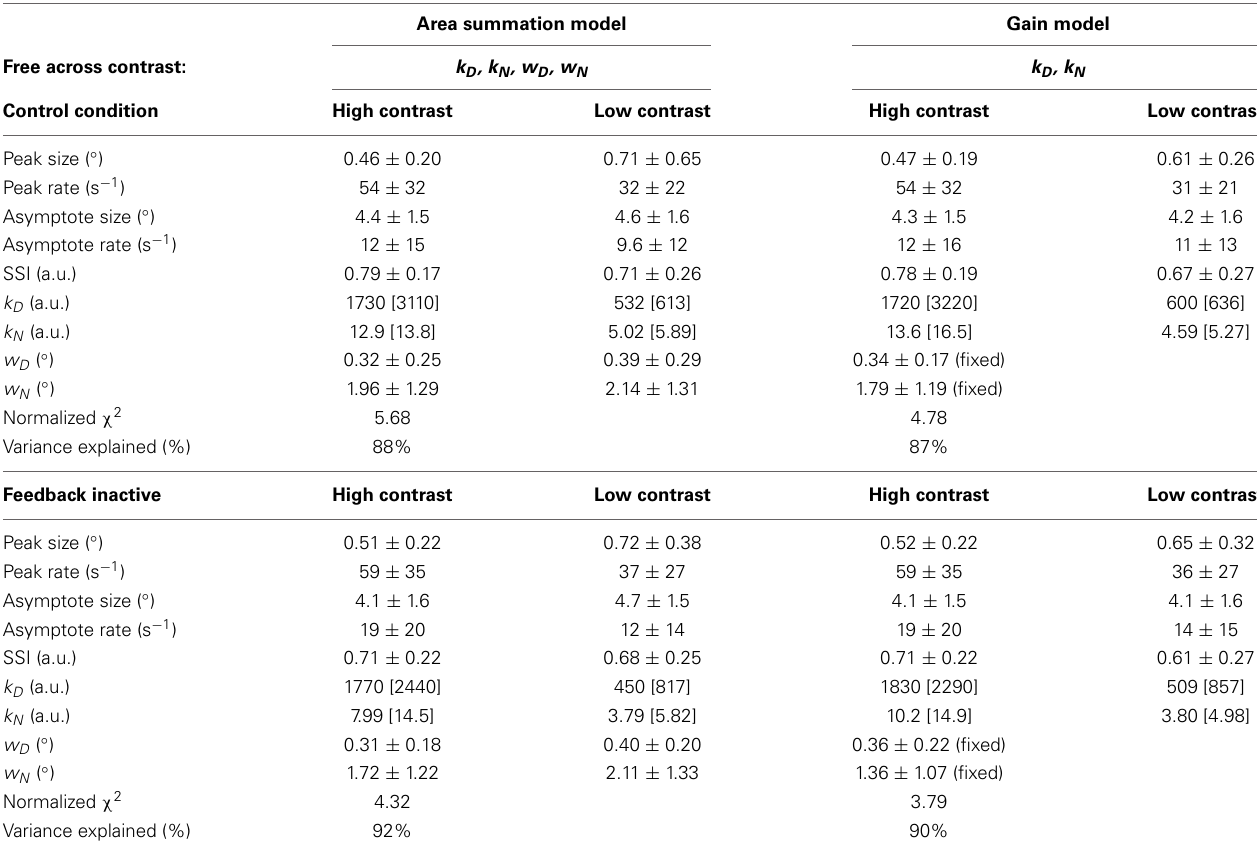
Table 4 | Comparison of area summation model and gain